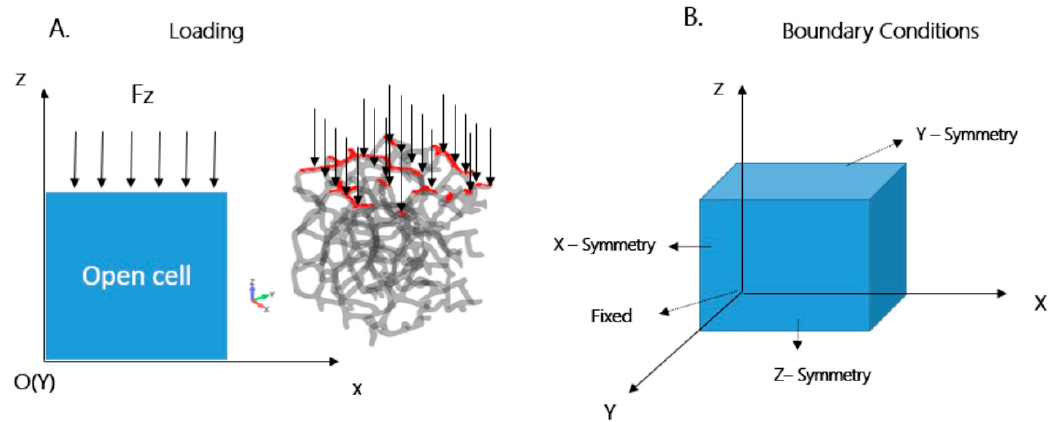
Figure 2. Schematic representation of boundary conditions: ( A ) uniform compressive loading of 20 N, only in the z -axis direction, over the entire upper surface of the sample; ( B ) symmetrical boundary conditions applied in the respective directions.